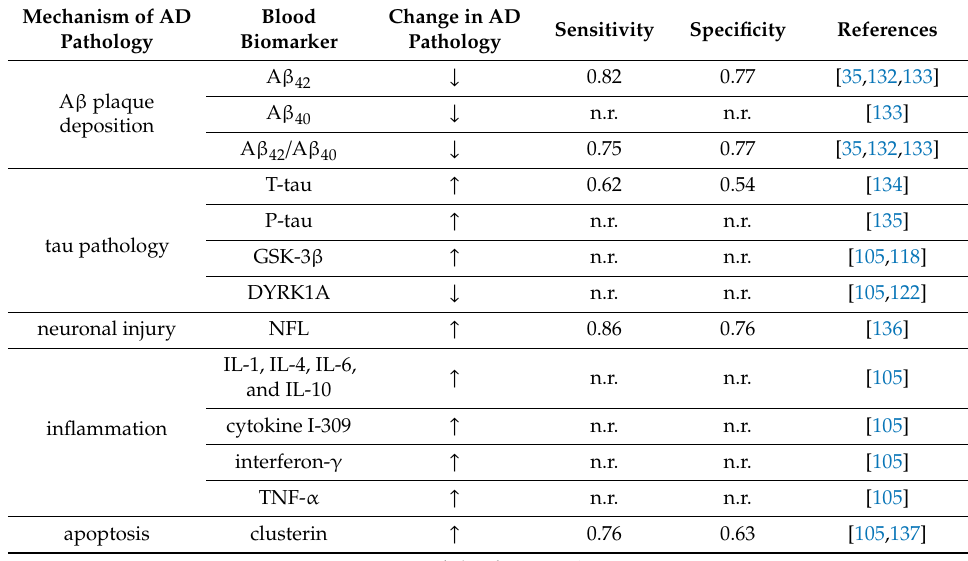
Table 2. The major changes of the identified blood biomarkers for AD and the associated mechanisms of